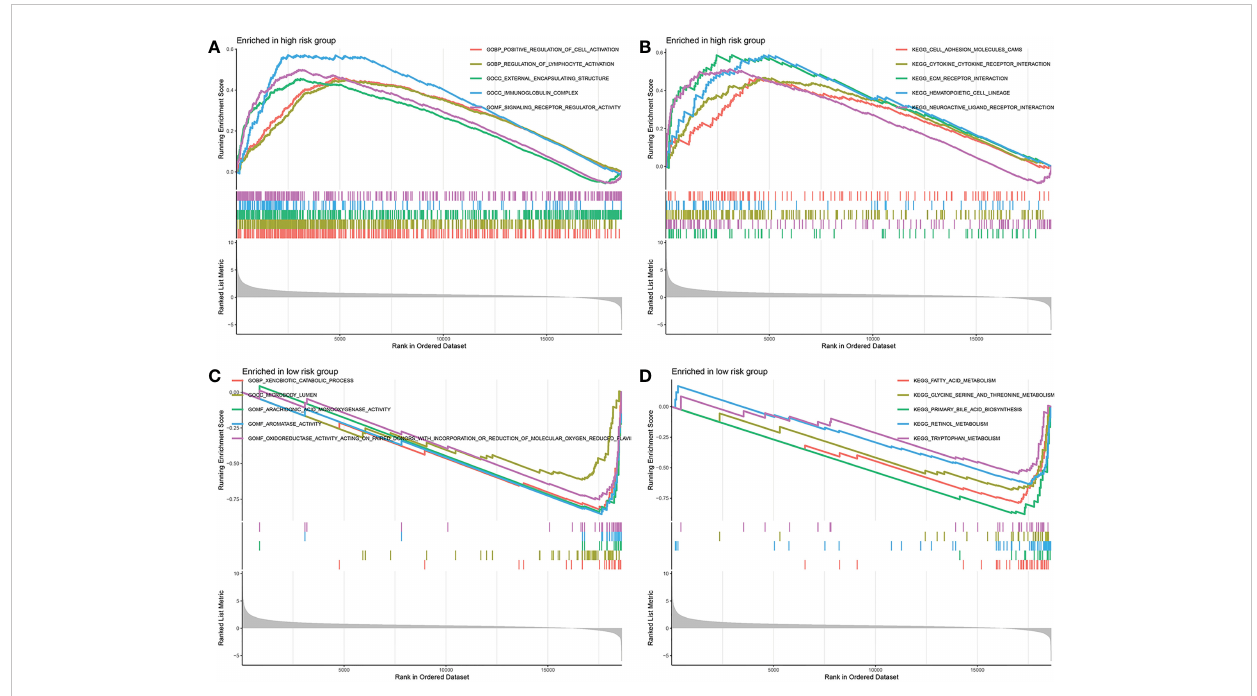
FIGURE 9 Gene set enrichment analysis. (A, B) Biological activities enriched in the high-risk group. (C, D) Biological activities enriched in the low-risk